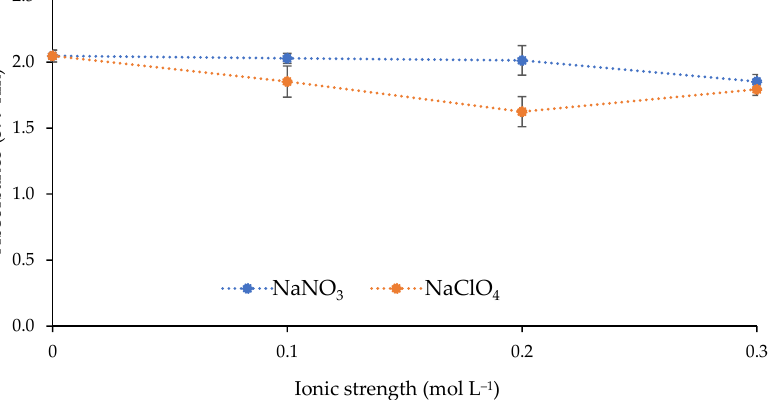
Figure 6. Effect of the ionic strength on the sensor response (1 mg L − 1 Cd(II); pH 9.5; 0.337 mol L − 1 buffer; n = 2).